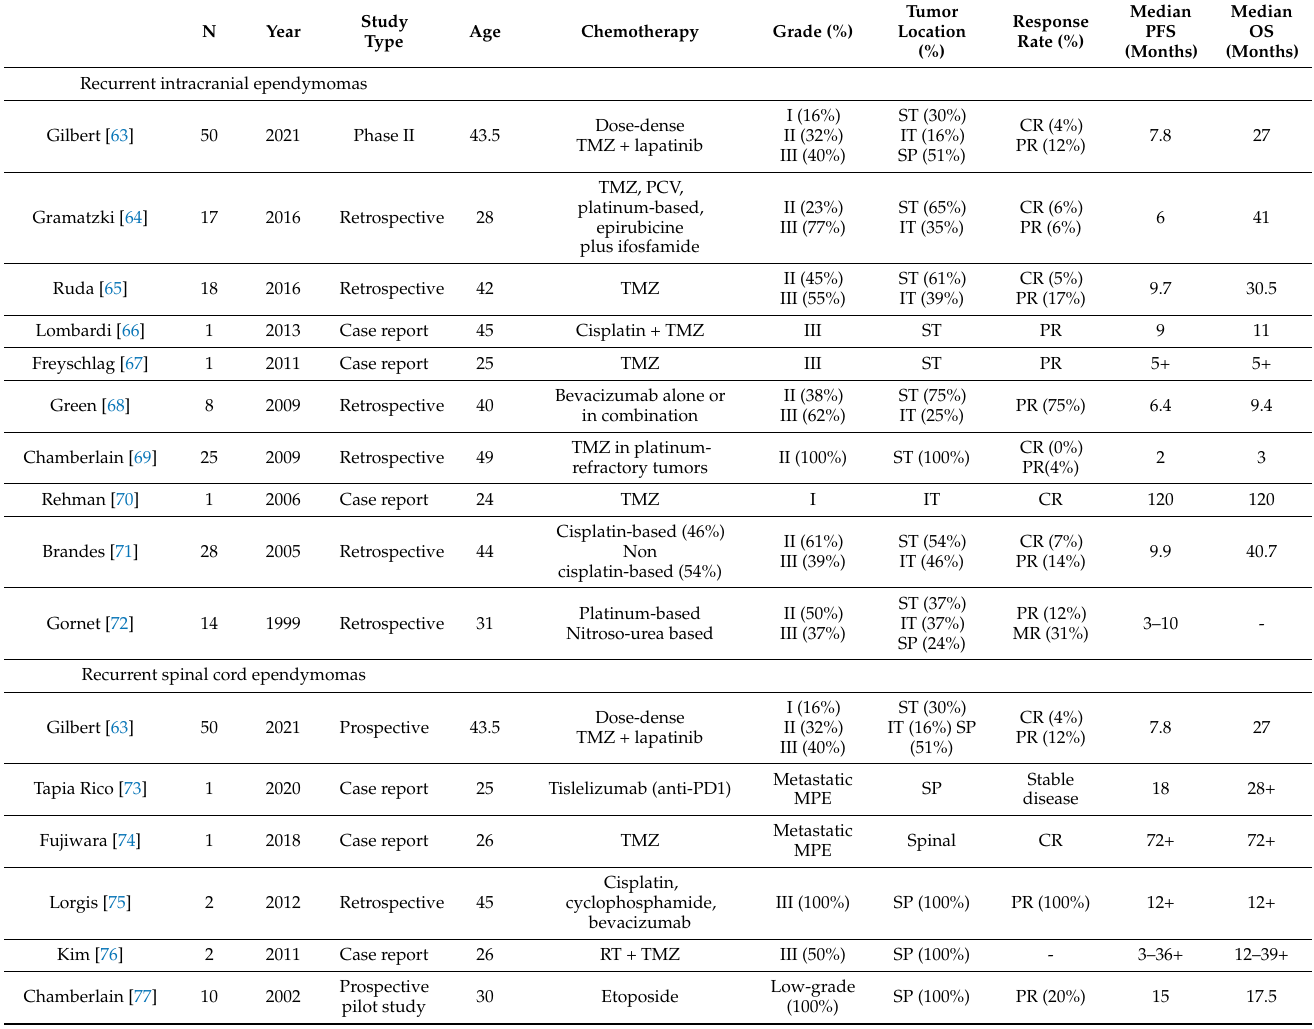
Table 4. Summary of studies and case reports analyzing the impact of chemotherapy in recurrent adult intracranial and spinal ependymomas. PFS = progression-free survival; OS = overall survival; ST = supratentorial; IF = infratentorial; SP = spinal; CR = complete response; PR = partial response; MR = minimal response; RT = radiation therapy; TMZ = temozolomide; PCV = procarbazine, carmustine, vincristine; MPE = myxo-papillary ependymoma.